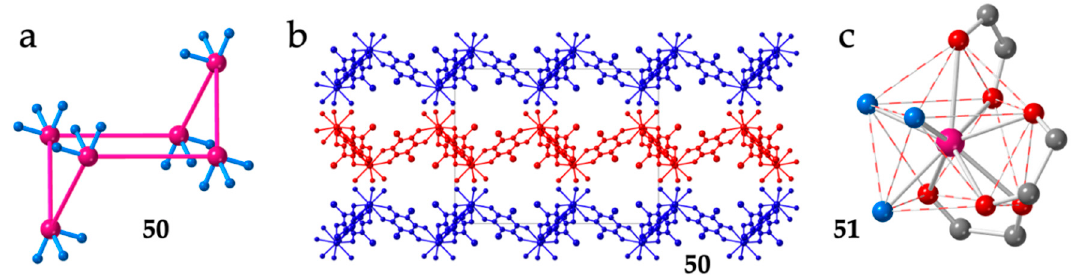
Figure 7. ( a ) Side view of one hexagonal ring in compound 50 . ( b ) View of three consecutive layers in compound 50 . The solvent molecules have been omitted for clarity. ( c ) View of the coordination environment of the Dy(III) ion in compound 51 . Colour code: Ln = pink, C = grey, O anilato = red and O dmf = blue.